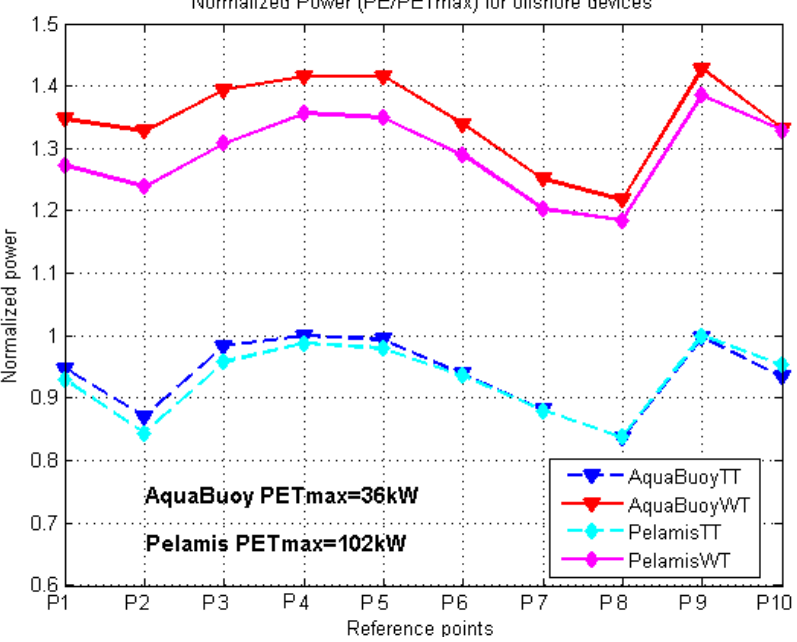
Figure 6. Normalized electric power for the offshore devices in the reference points (from north to south) corresponding to total (TT) and winter time (WT), respectively.